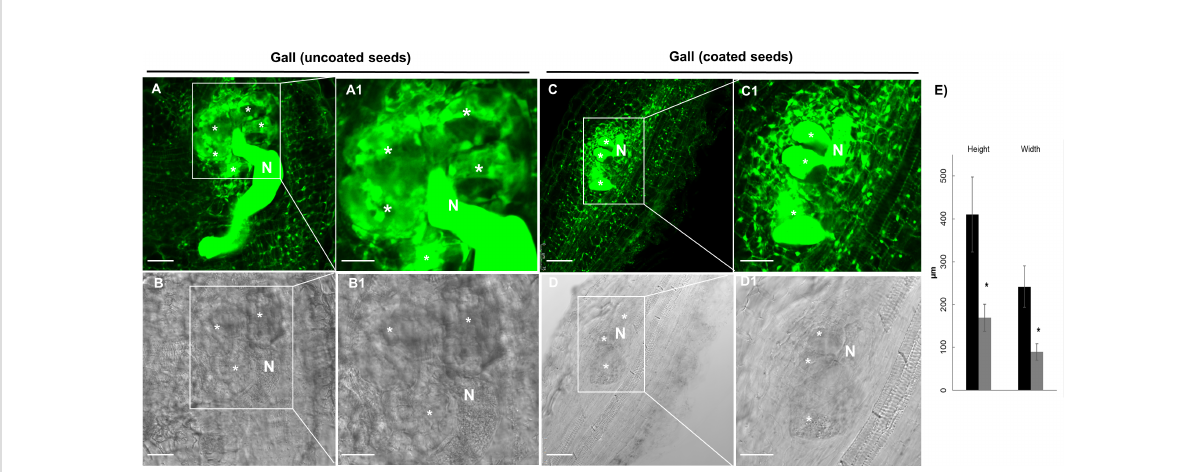
FIGURE 5 Representative confocal images of tomato, Solanum lycopersicum (L.) cv. Roma VF, root-galls infected with M. javanica at 14 dpi from bacteria- treated (coated seeds) and non-treated, control plants. (A) Auto- fl uorescence of the glutaraldehyde (green), and (B) Transmission images of control (untreated) gall from tomato at 14dpi, (C) Fluorescence of the glutaraldehyde (green), and (D) Transmission images of galls from bacteria treated plants with seeds coating. A1 , B1 , C1 , D1 ), close up images of the giant cells (GCs) and the nematode as indicated, to facilitate their observation. The GCs size showed differences between those treated with the dual-strain bacteria combination and tomato control galls;*, giant cells; N, nematode; Scale bars: 75µm. (E) Quanti fi cation of the GCs size. Bars represent mean of giant cells size (height and width) ± SE for fi fty giant cells per treatment, from three independent experiments. *Asterisks represent signi fi cant differences respect to uncoated seeds (t-test; P<0.05). Seeds were uncoated (black) or coated (grey) with the dual-strain bacteria combination of B paralicheniformis FMCH001 and B subtilis FMCH002.